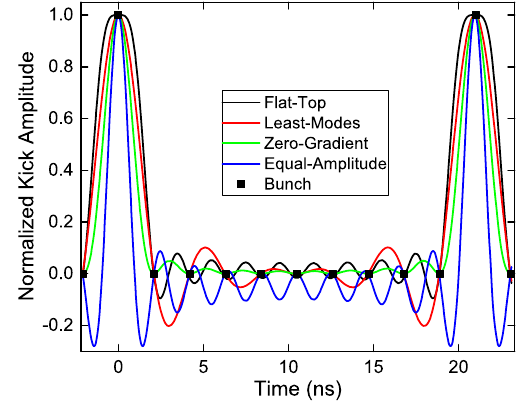
FIG. 3. Four different synthesized kick waveform schemes for a recirculating factor of 10 and bunch repetition frequency of 476.3